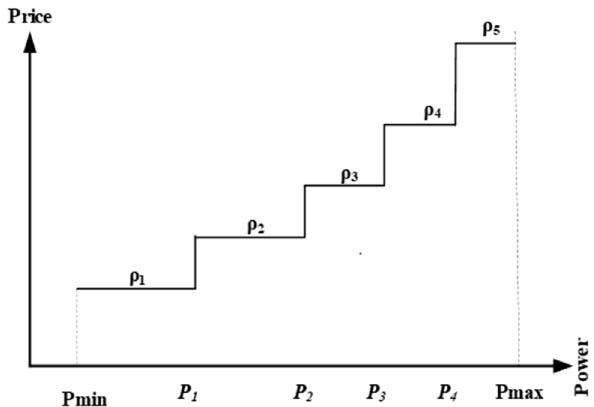
Figure 2. Characteristics of the offer function.